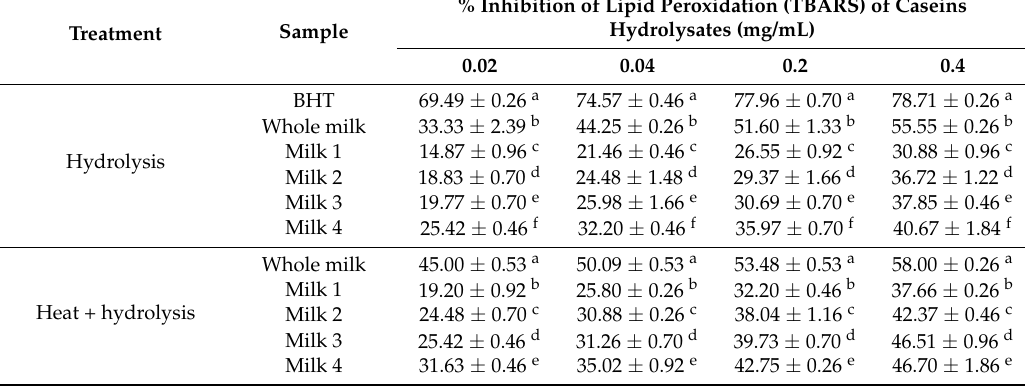
Table 1. Antioxidant activity of native and heated casein hydrolysates obtained of whole cow milk and four commercial cow milk from Ecuador.